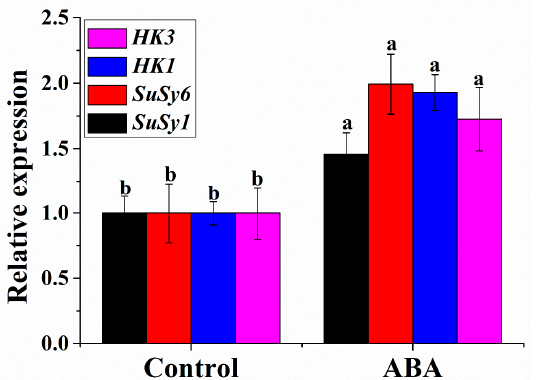
Figure 4. Effects of exogenous 0.05 μ M ABA on the expression levels of CsSuSy1 , CsSuSy6 , CsHK1 and CsHK3 genes in hypocotyls of cucumber. The values (means ± SE) are the averages of three independent experiments. The different letters above the bars indicate significant differences ( p < 0.05) according to one-way ANOVA and t test.